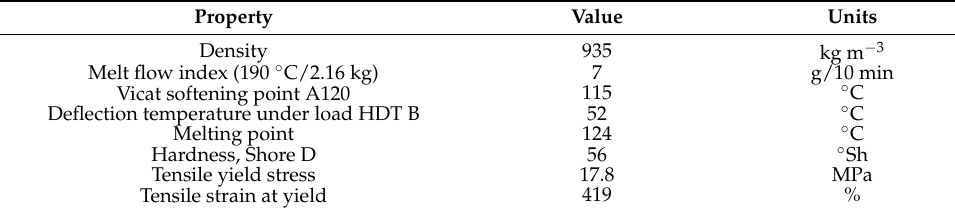
Table 1. Selected properties of Dowlex